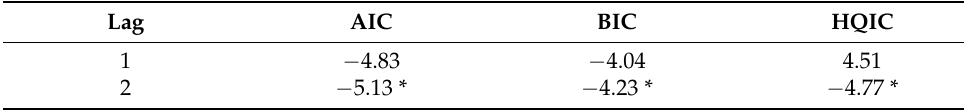
Table 9. Test results of optimal lag